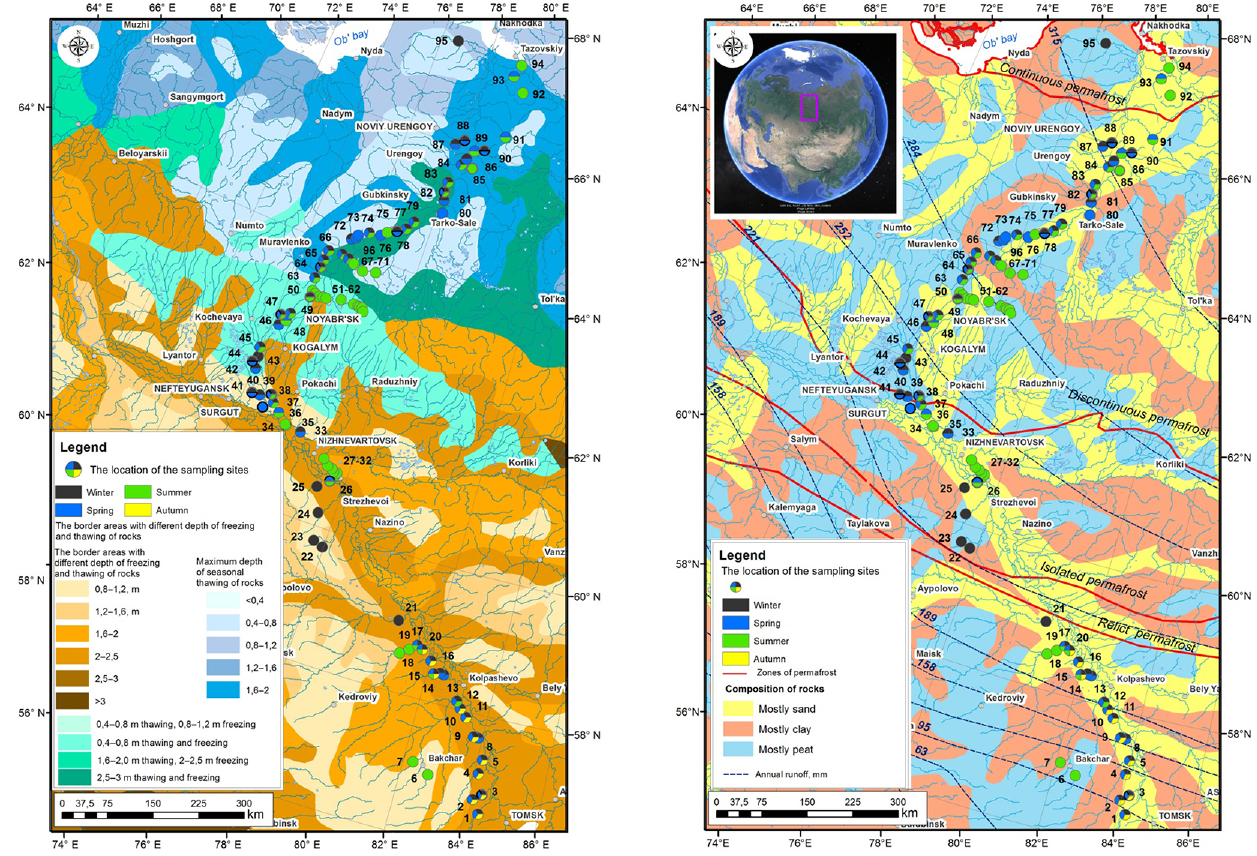
Figure 1. Scheme of sampled rivers in the Western Siberian Lowland (WSL) together with lithological information and thawing soil